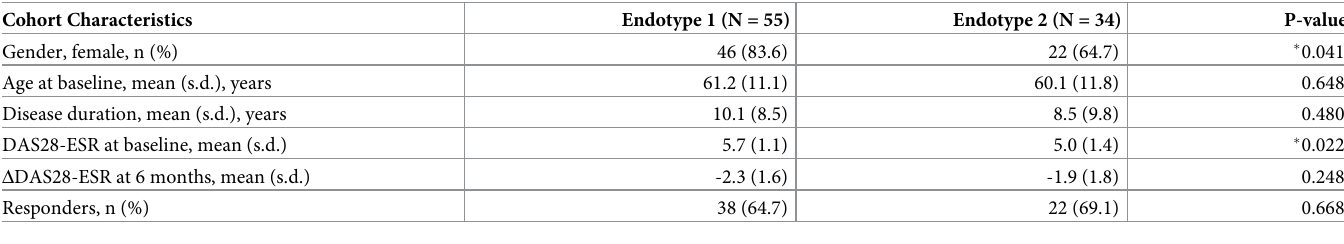
LOOCV of the first 20 PCs, which gave top 20, 6, and 4 PCs with minimum predicted sum of squares (PRESS) for na ï ve, approximate, and pseudoinverse approaches, respectively (S1B Fig). Although the na ï ve approach has limitations [53], all three LOOCV approaches suggested that at least first 4 PCs are important. The first two principal components (PC1 and PC2) did not show any segregation; however, the third principal component (PC3) was able to subdivide patients into two distinct clusters i.e., endotypes (Fig 1). The demographic and clinical features for each cluster are shown in Table 2. A statistically significant difference (p < 0.05) in baseline DAS and gender was noted between the two clusters. Age, disease duration and anti-TNF bio- logic treatment response were not significantly different between the two clusters. The associa- tion between baseline DAS and gender within the clusters is illustrated in Fig 1. The plot indicates a relatively higher baseline DAS and a higher proportion of females in the cluster positioned in the upper/positive PC3 quadrant. It appears that the two endotypes clearly dis- tinguish patients based on disease activity and are gender dependent. Table 2. Demographic and clinical features of two molecular sub-class or endotypes presented in Fig 1. Gender and baseline DAS values were found to be statistically significant between the two endotypes. DAS28-ESR = Disease activity score with 28-joint counts and erythrocyte sedimentation rate. Cohort